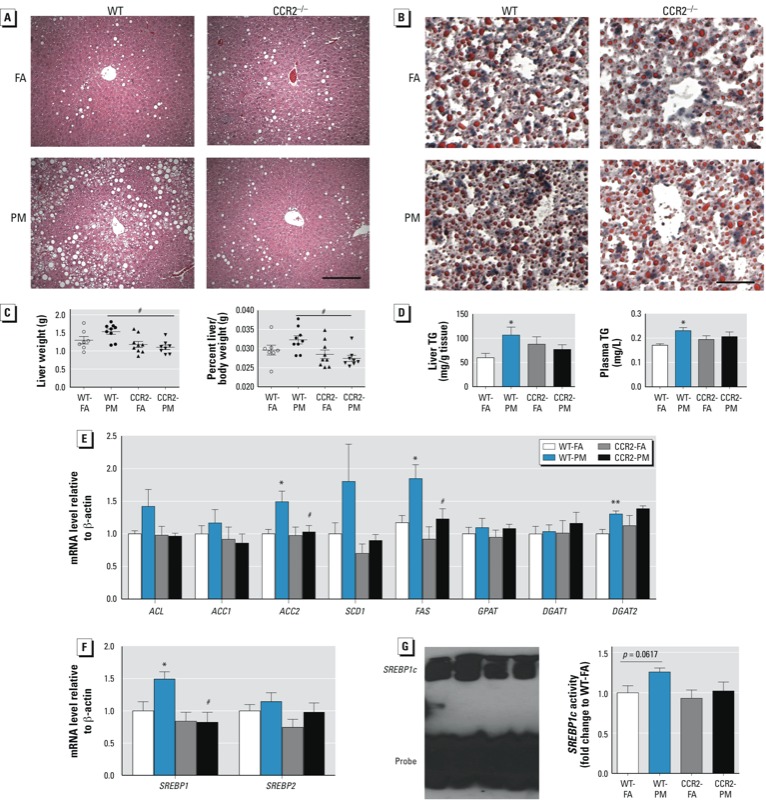
Effect of PM2.5 exposure and an HFD on lipid homeostasis in WT and CCR2–/– mice; animals were exposed to PM2.5 or FA for 17 weeks. (A) Representative images of H&E-stained liver sections; bar = 100 μm. (B) Representative images of oil red O–stained liver sections; bar = 25 μm. (C) Liver weight (left) and liver weight/body weight ratio (right). (D) TG levels in liver (left) and plasma (right). (E) mRNA levels of genes involved in de novo lipid synthesis in the liver. (F) mRNA levels of SREBP1 and SREBP2. (G) The DNA binding activity of SREBP1c in the liver. Data are presented as mean ± SE of 7–9 mice/group.
*p < 0.05 for WT‑PM compared with WT‑FA. #p < 0.05 for CCR2‑PM compared with the WT‑PM group.